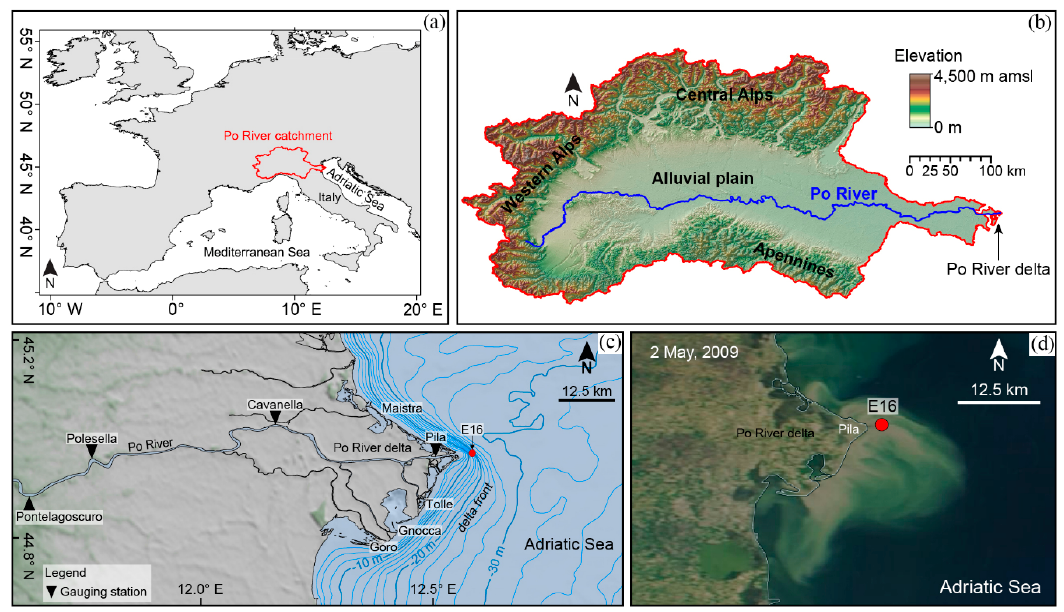
Figure 1. ( a ) Location of the Po River catchment in Italy; ( b ) elevation map; ( c ) location of the gauging stations downstream of Pontelagoscuro, in the lowland part of the Po River; ( d ) locations of the Pila gauging station and the core sample E16.